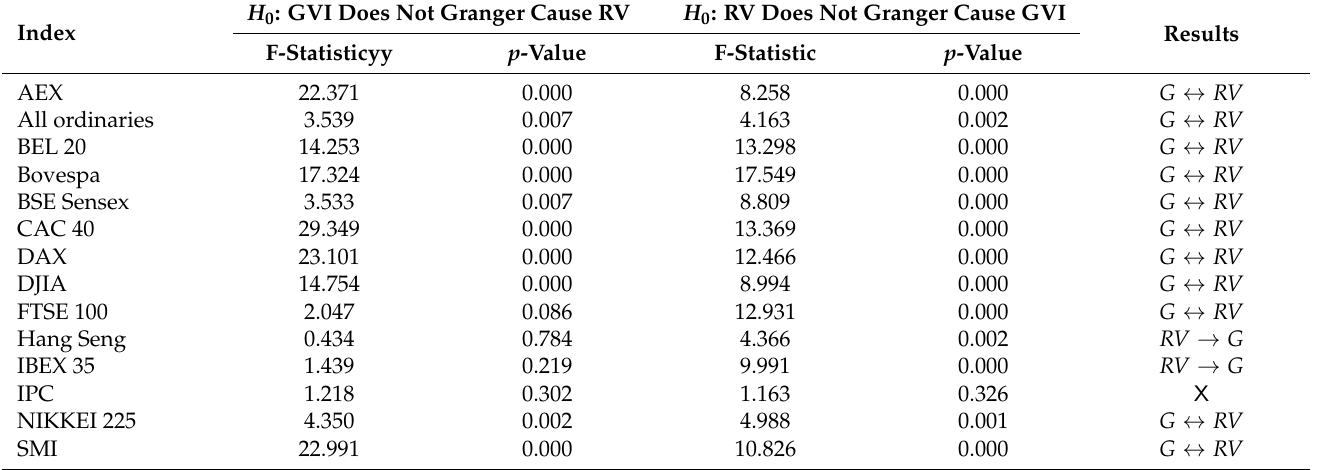
Table 3. Linear Granger causality